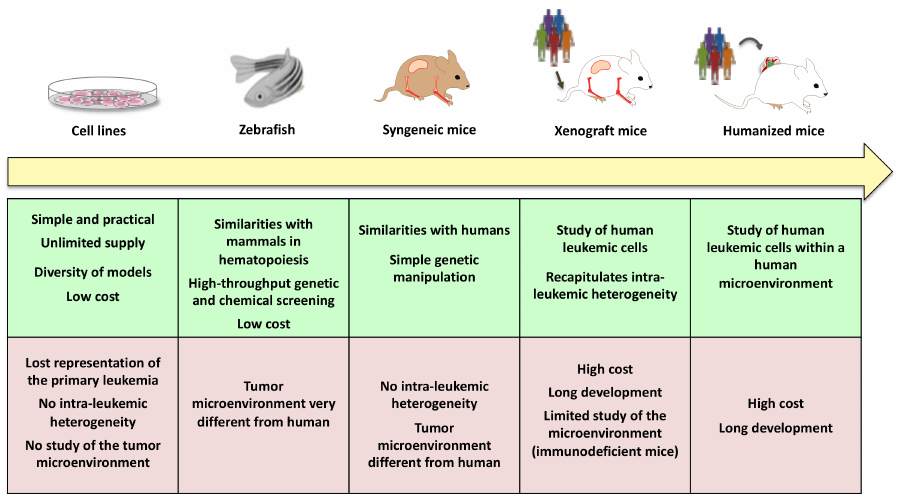
Figure 4. AML models over time: main advantages and drawbacks. This schema highlights several models used throughout the years (yellow arrow) for a better understanding of AML leukemogen- esis. Green and purple boxes represent respectively the main advantages and drawbacks of each AML